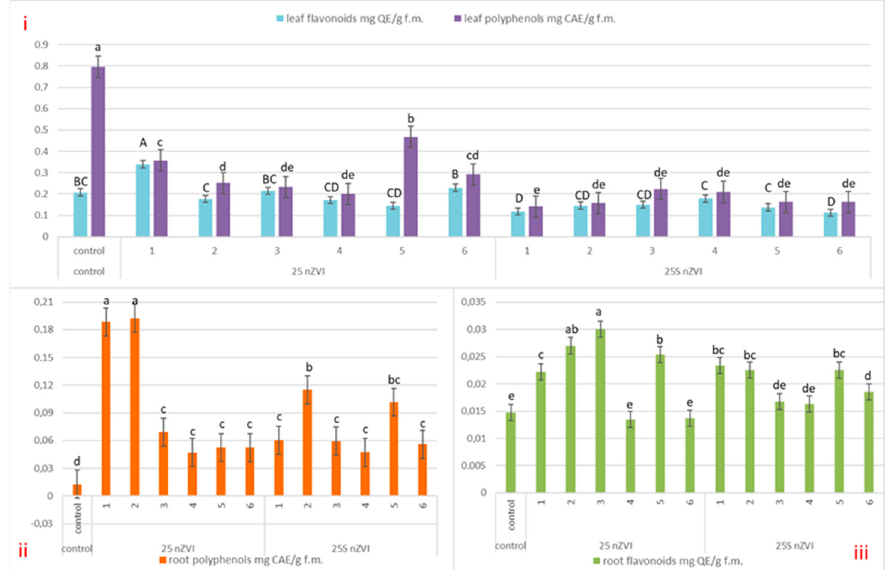
Figure 4. The content of polyphenols and flavonoids in the shoots ( i ) and content of flavonoids ( ii ) and polyphenols ( iii ) in roots of plants grown on soil contaminated with 25 and 25S nZVI. The numbers 1–6 correspond to the following concentrations: 0.5; 1; 5; 10; 50 and 100 g nZVI/kg soil. Vertical bars represents the mean values (n = 5) ± standard deviations. Different letters indicate significant difference at p < 0.05 by LSD test.